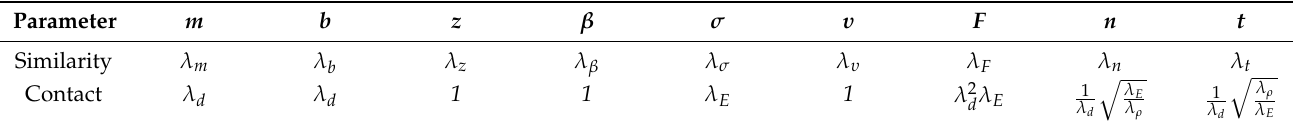
Table 5. Parameter similarity